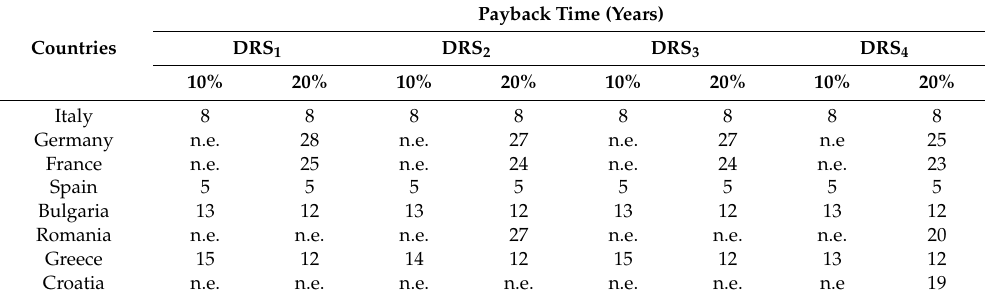
Table 18. Payback time for increment of power equal to 10% and 20%. In some cases the payback